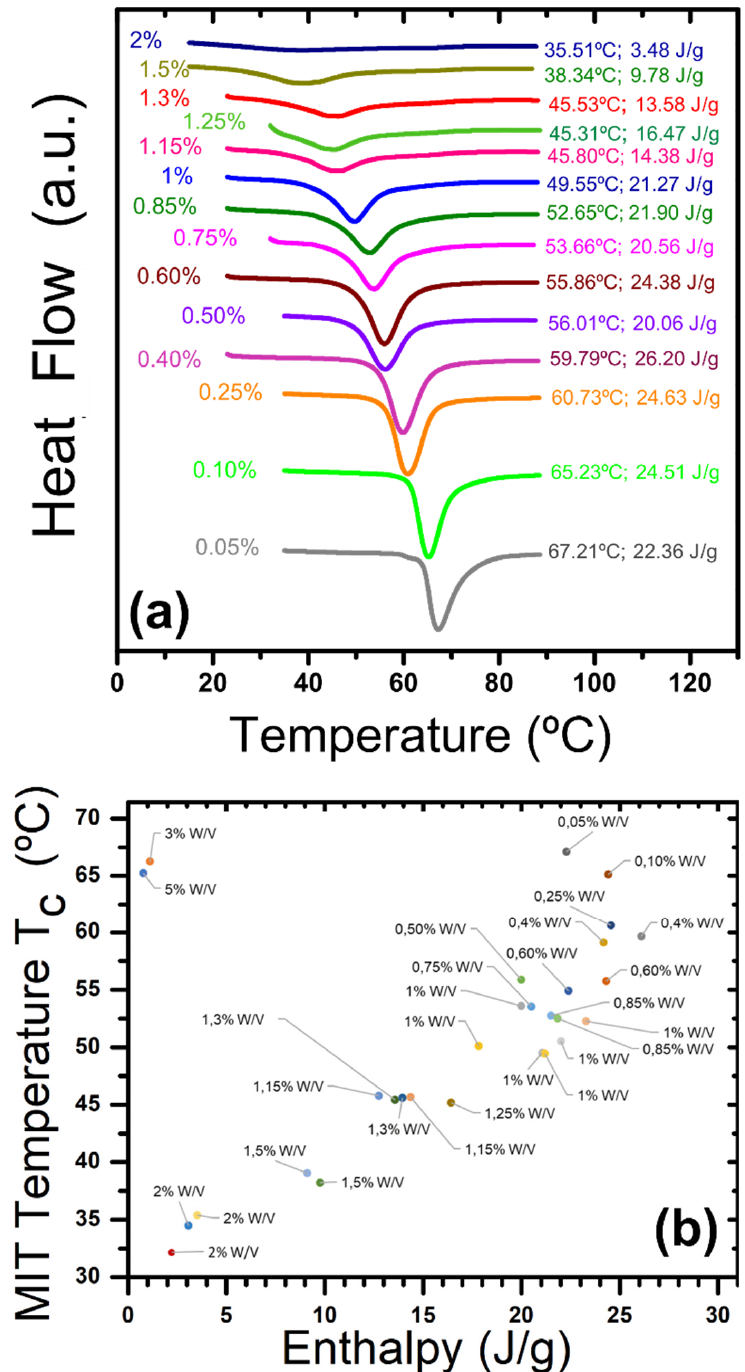
Figure 6. ( a ) DSC endothermic peaks for most of the tested compositions. ( b ) Tc vs. Δ H for all W doping trials of 2 cycles.